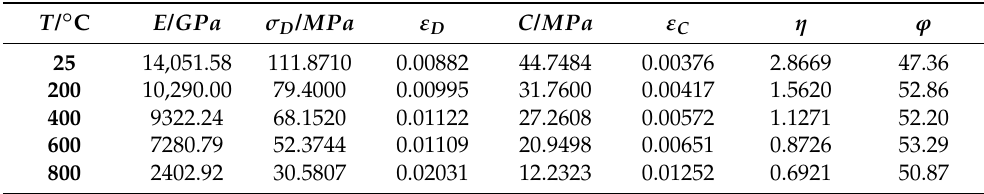
Table 1. Parameters of the uniaxial compression experiment on Beishan granite with different temperature treatments.